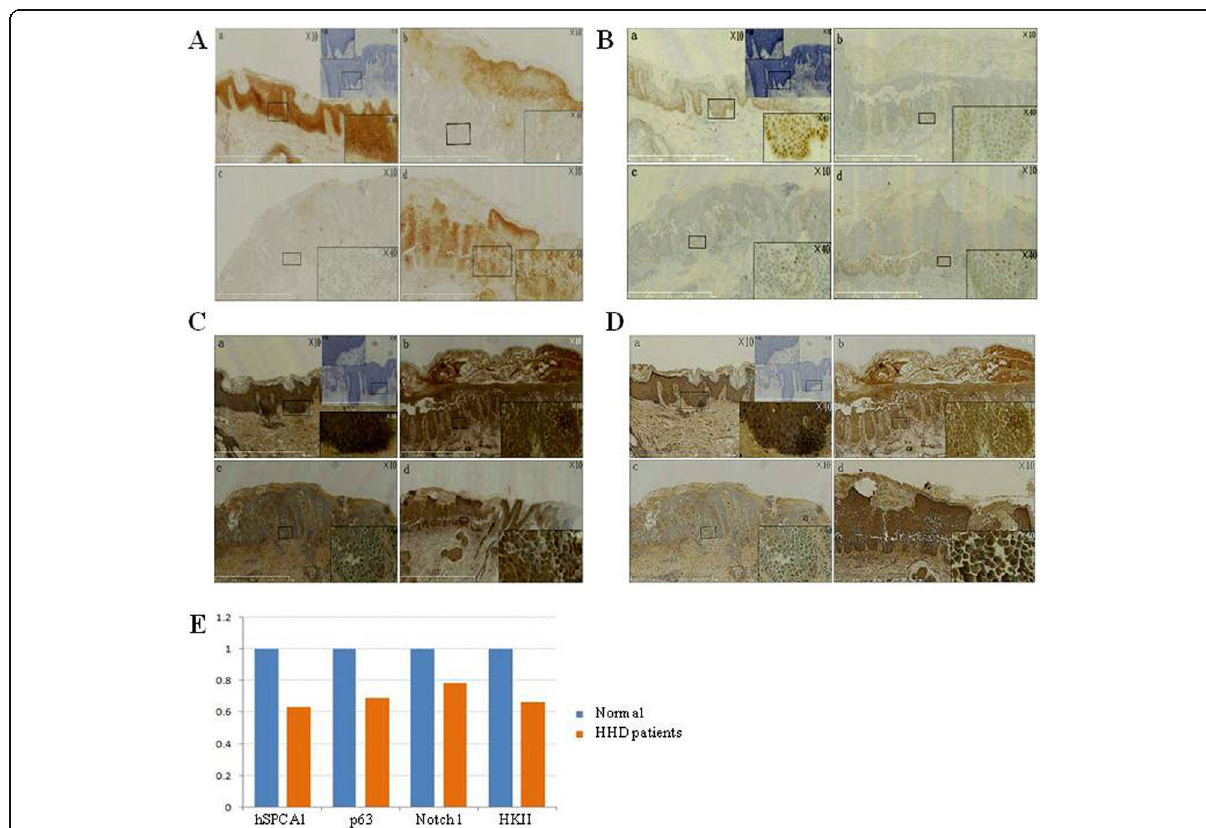
Fig. 7 (A) IHC staining for ATP2C1 [Negative control with PBS(a) and expression levels of hSPCA1 in HHD(b,c,d)]. (B) IHC staining for p63[Negative control with PBS(a) and p63 protein in the nucleus of HHD patients(b,c,d)]. (C) IHC staining for NotchI in normal skin (a) and HHD (b,c,d). (D) IHC staining for HKII in normal skin(a) and HHD patients(b,c,d). (E). Quantification for IHC staining signals in A ~